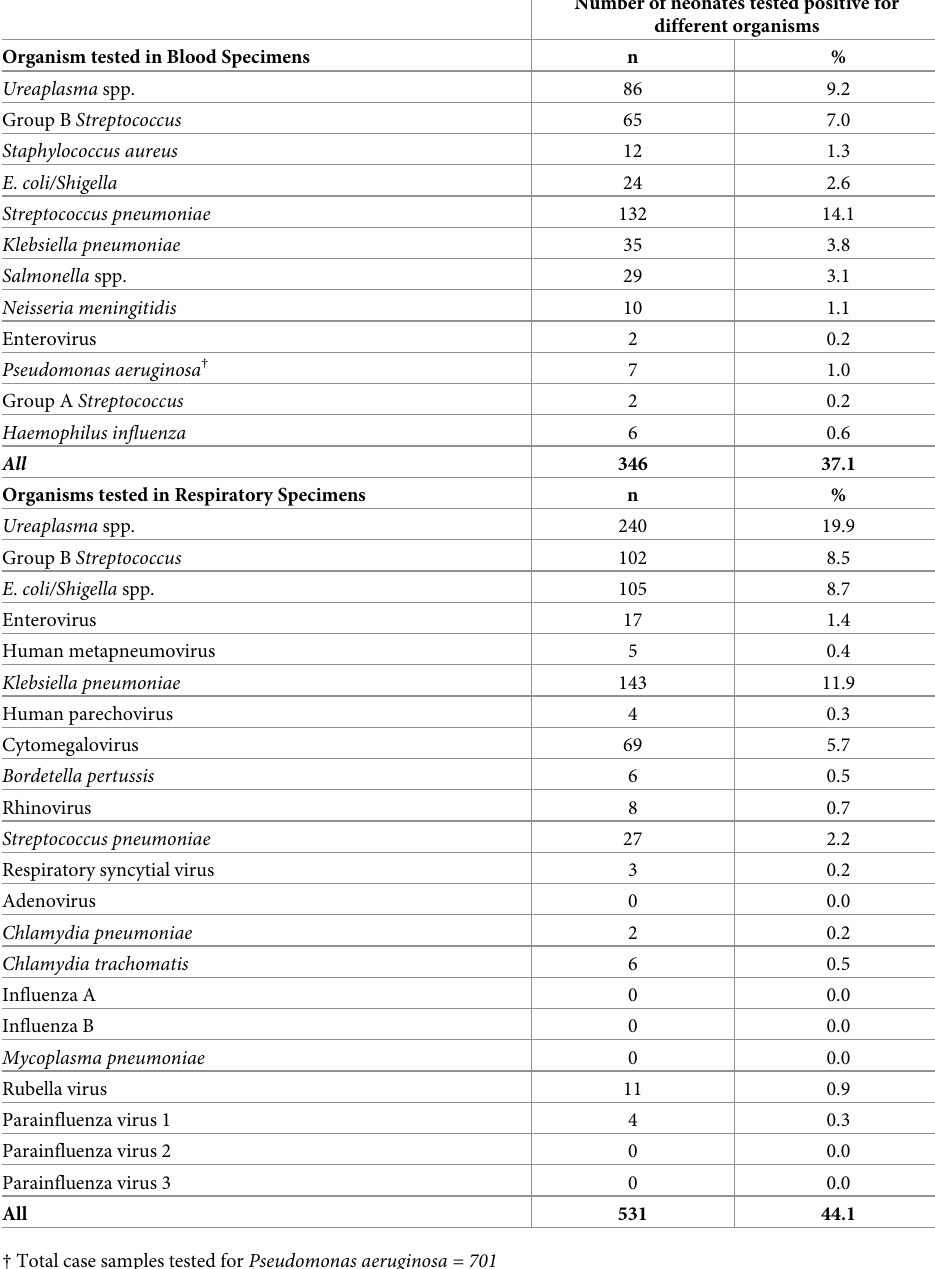
Number of neonates tested positive for different organisms